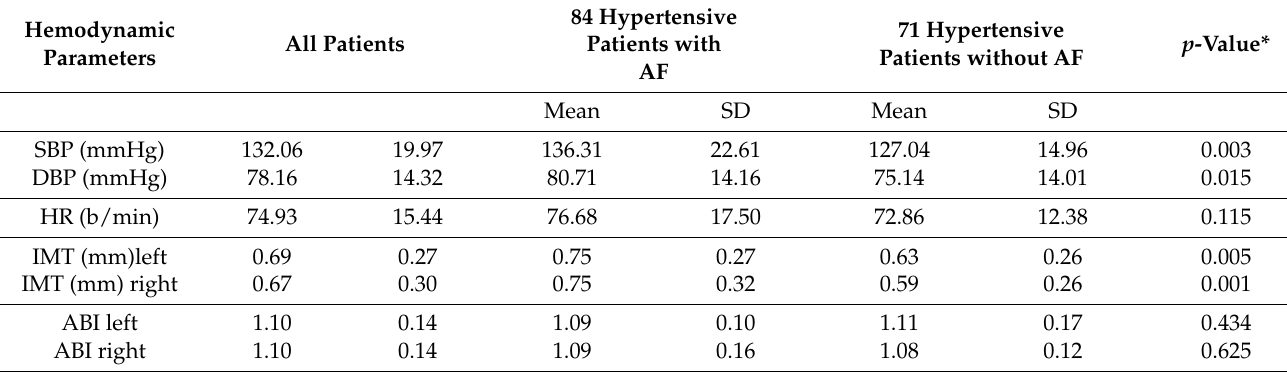
Table 3. Hemodynamic parameters, IMT, and ABI in hypertensive patients with/without AF.